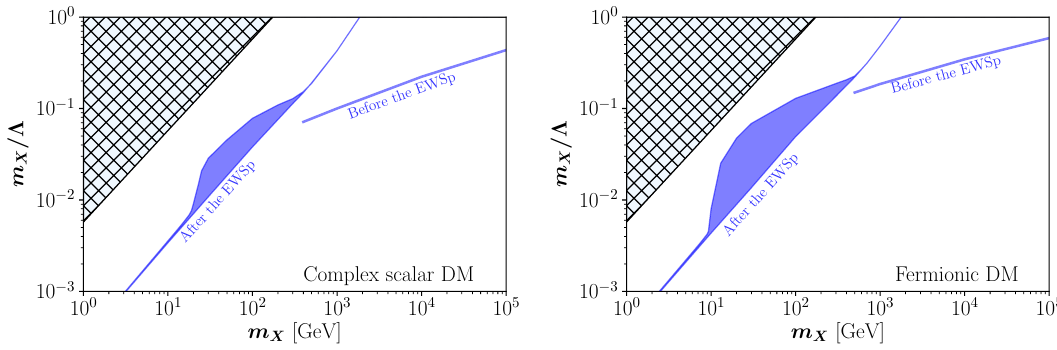
Figure 1 . Regions of ( m X ; (cid:3)) plane characterized by the fact that the measured baryon asymmetry of the Universe and the DM relic abundance can be reproduced simultaneously, in the case of complex scalar (left panel) and fermionic (right panel) DM, and for the scenarios where the transfer of the asymmetry is e(cid:14)cient before (with operator (2.6)) and after the freeze-out of the EWSp processes (with operator (2.7)). Figure adapted from ref.